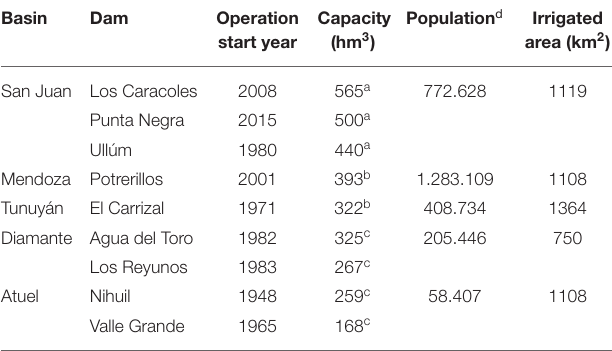
TABLE 3 | Dams, population and irrigated area in each river